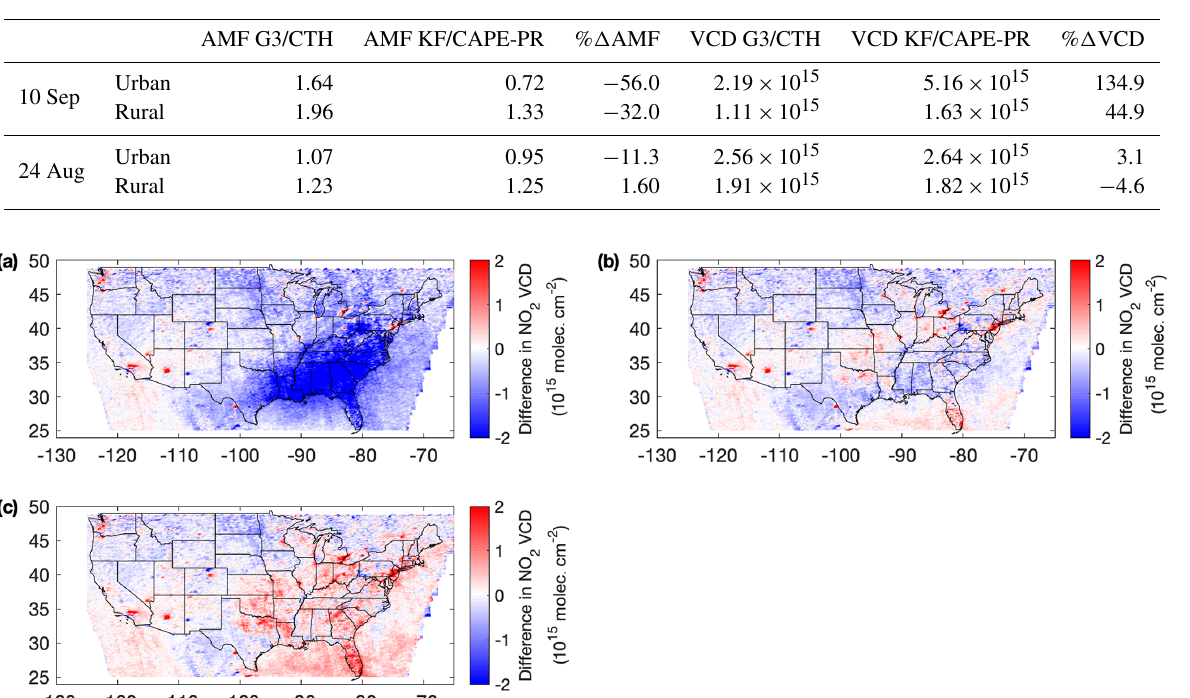
Table 2. Differences for BEHR AMFs and tropospheric VCDs when using the a priori NO 2 profiles from models with CTH vs. CAPE-PR parameterizations in the AMF calculation. For definitions of “urban” and “rural”, see the text.